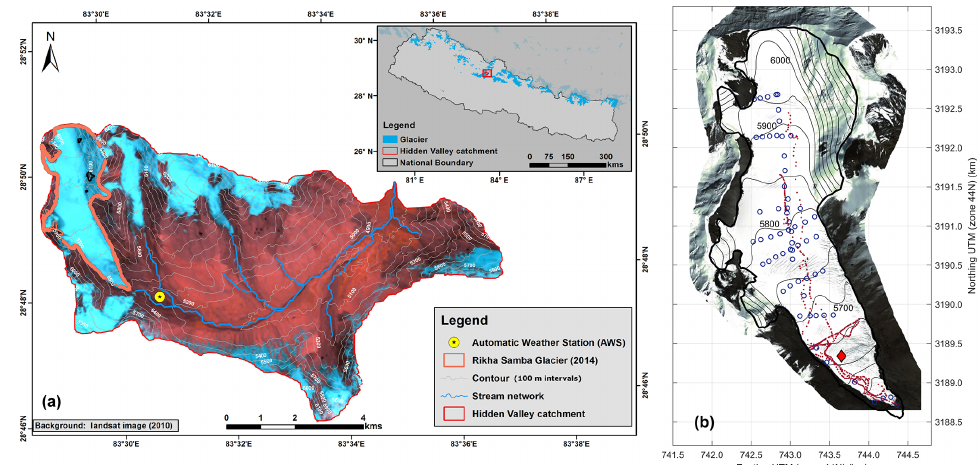
Figure 1. (a) Location and (b) map of Rikha Samba Glacier in the Hidden Valley catchment in Nepal. Radar tracks in 2015 (red dots), radar point measurements in 2010 (blue circles) and location of the thermistor chain (red diamond) are shown in (b) . Background image of (a) is from Landsat 5 on 25 May 2010. Background image of (b) is from Google Earth (image © 2020 Maxar